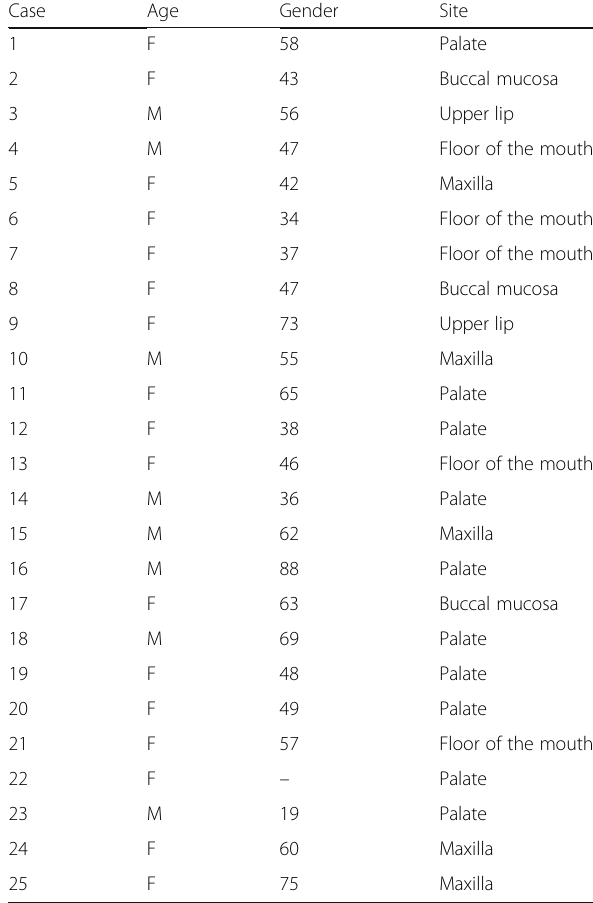
Table 1 Clinical features of the ACC evaluated